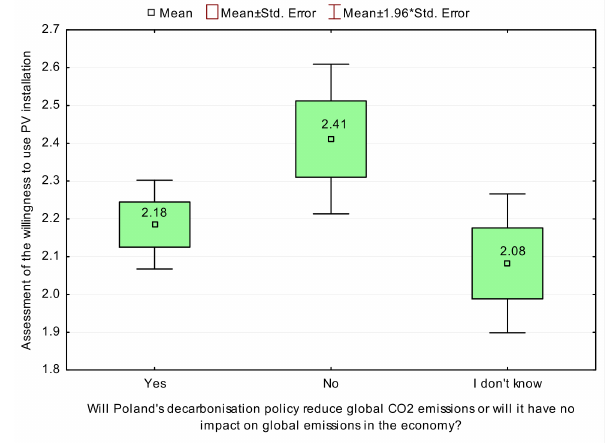
Figure 7. Will the decarbonization policy in Poland contribute to reducing global CO 2 emissions vs. assessment of the willingness to use PV installations.